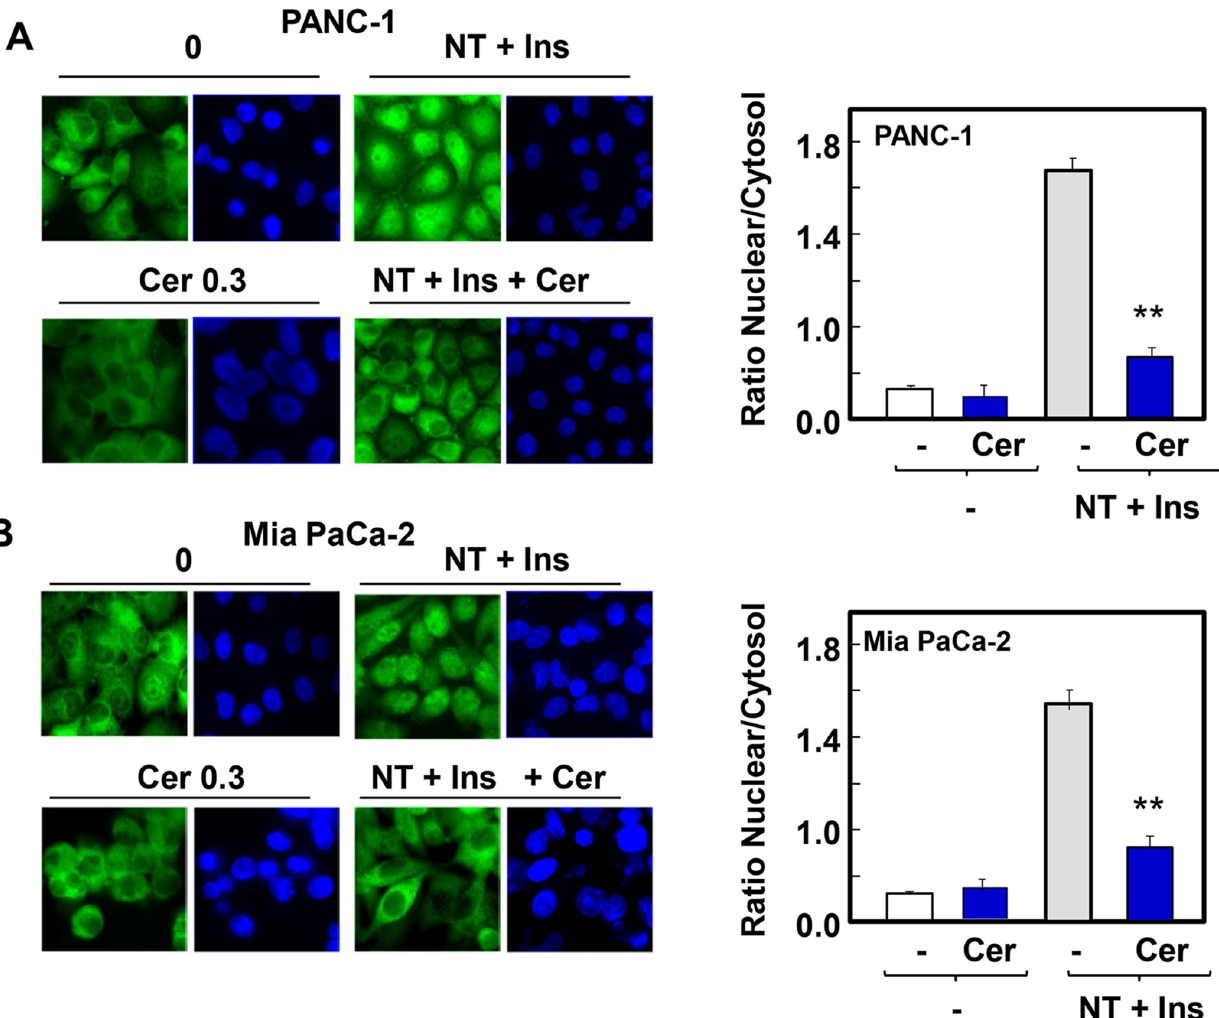
Fig 2. Cerivastatin inhibits YAP nuclear localization induced by stimulation with neurotensin and insulin in confluent PDAC cells. Confluent cultures of PANC-1 (A) or Mia PaCa-2 (B) cells were incubated either in the absence or presence of 0.3 μ M cerivastatin (Cer) for 24 h. The cultures were then stimulated without (-) or with a combination of 5 nM neurotensin and 10 ng/ml insulin (NT+Ins) for 60 min. The cultures were then washed, fixed with 4% paraformaldehyde and stained with an antibody that detects total YAP and with Hoechst 33342 to visualize the cell nuclei. Bars represent the ratio of nuclear/cytoplasm (100 to 125 cells). Cerivastatin significantly decreased NT+Ins nuclear localization of YAP as compared with untreated controls ( �� P < 0.01) as shown by t-test.